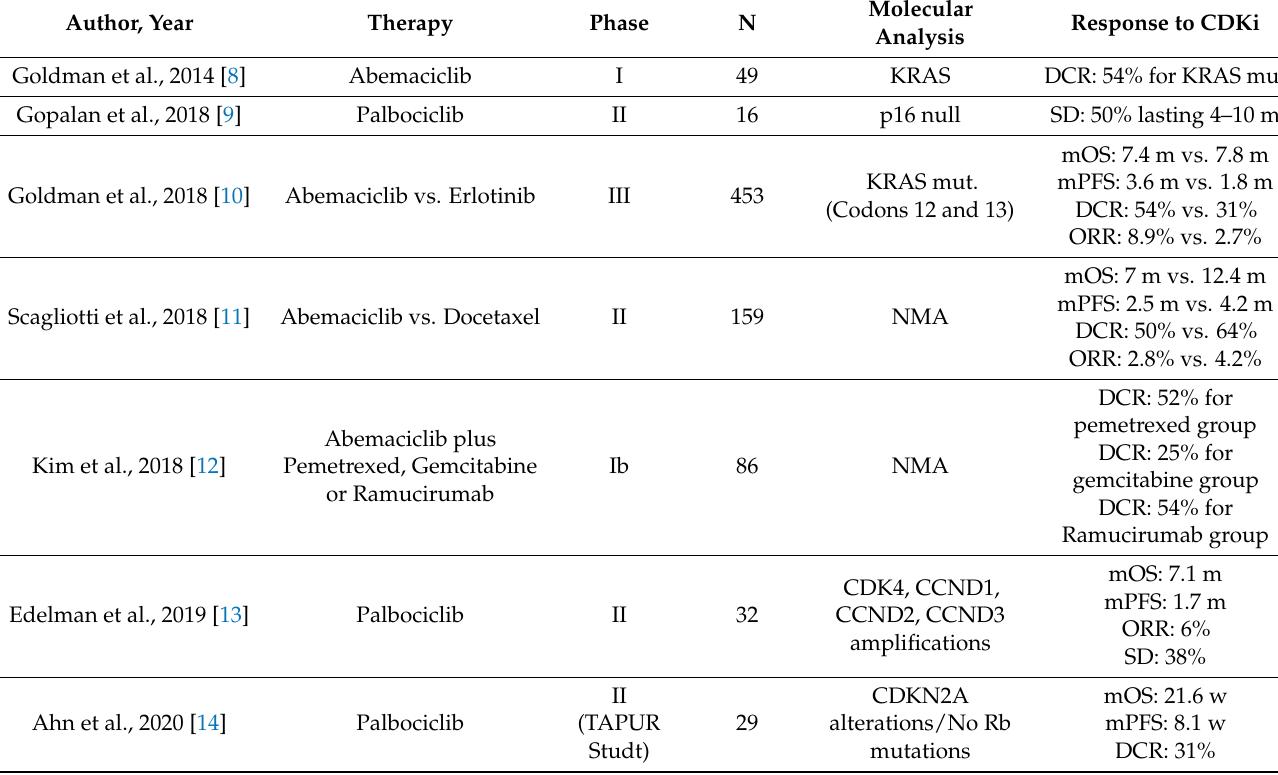
Table 1. Summary of clinical trials, including data on CDK4/6i in